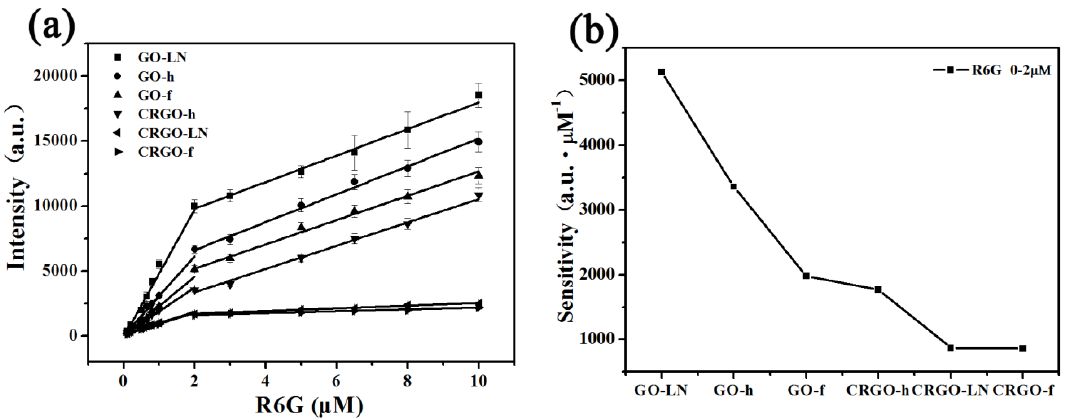
Figure 6. ( a ) The corresponding plots of Raman intensity of ~614 cm −1 peak of R6G deposited on GO and CRGO films vs. concentration; ( b ) the SERS sensitivity of R6G on GO and CRGO films in 0.1–2 × 10 −6 M R6G region.